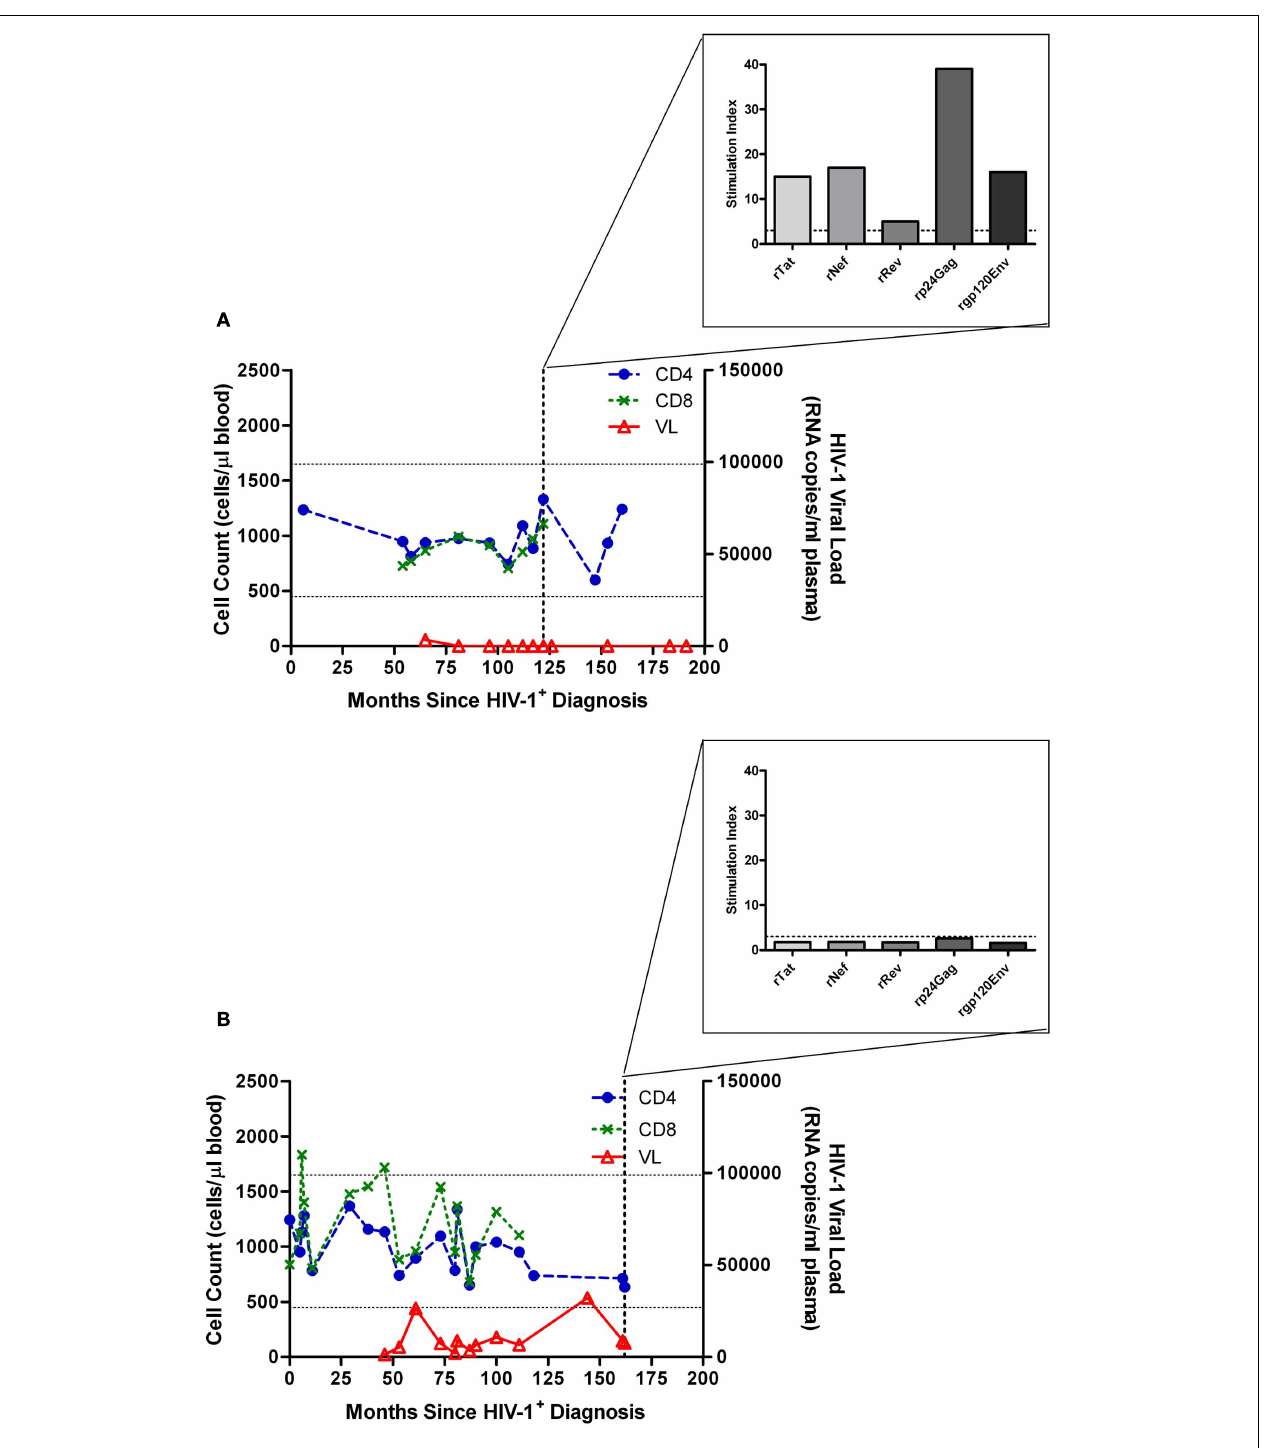
and (B) a typical lack of such responses in a chronically infected patient (Westrop et al., 2009b). Normal CD4T-cell range of 450–1650cells/ µ l blood is marked with horizontal lines.The threshold for positivity, stimulation index ≥ 3, is also marked with a dashed horizontal line (inset